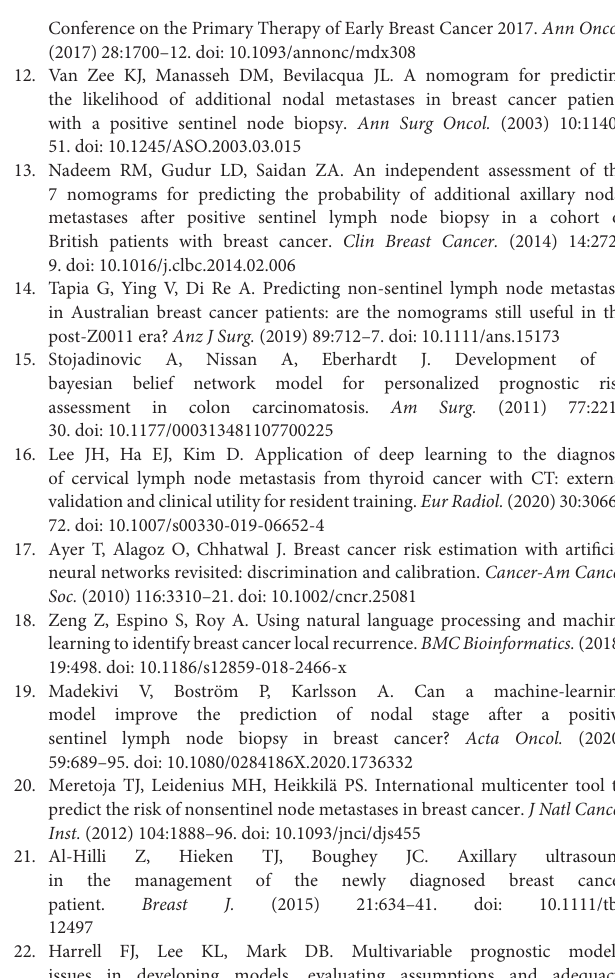
Supplementary Table S1 | Differences in clinicopathological characteristics between the training and validation sets. Supplementary Table S2 | Comparisons of the predictive performance of validation sets among the three algorithms